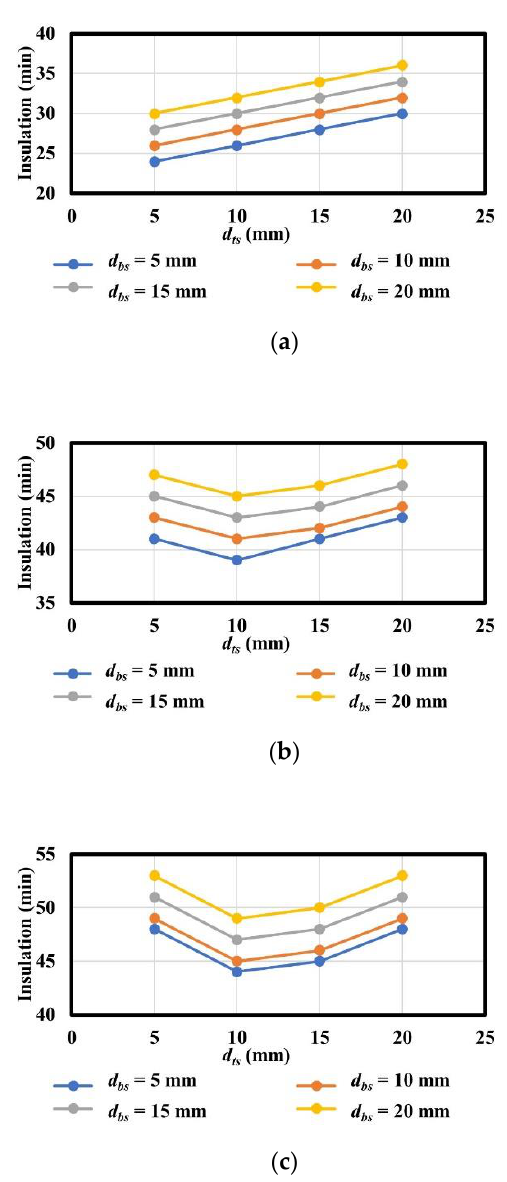
Figure 19. Summary of analysis results with constant d ts : ( a ) d p = 20 mm with varying d bs ; ( b ) d p = 40 mm with varying d bs ; ( c ) d p = 60 mm with varying d bs .